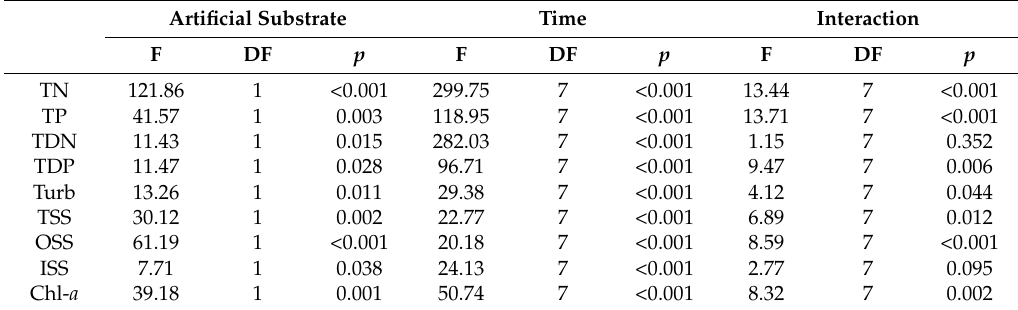
Table 1. Results of Analysis of Variance for repeated measures (rANOVA) for turbidity, suspended solids, nutrients, and Chl- a of phytoplankton between treatments with and without artificial substrate. Artificial